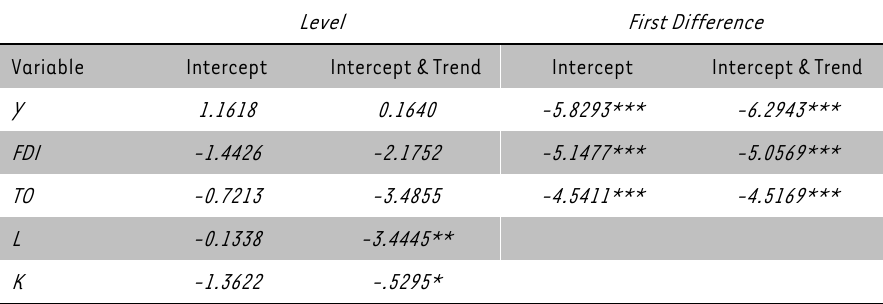
TABLE 1: Unit Roots Results Level First